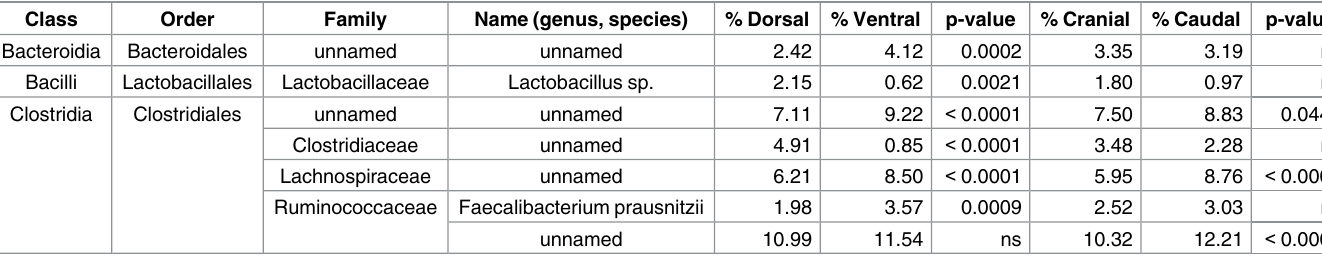
Table 1. Species level differences by anatomic region.